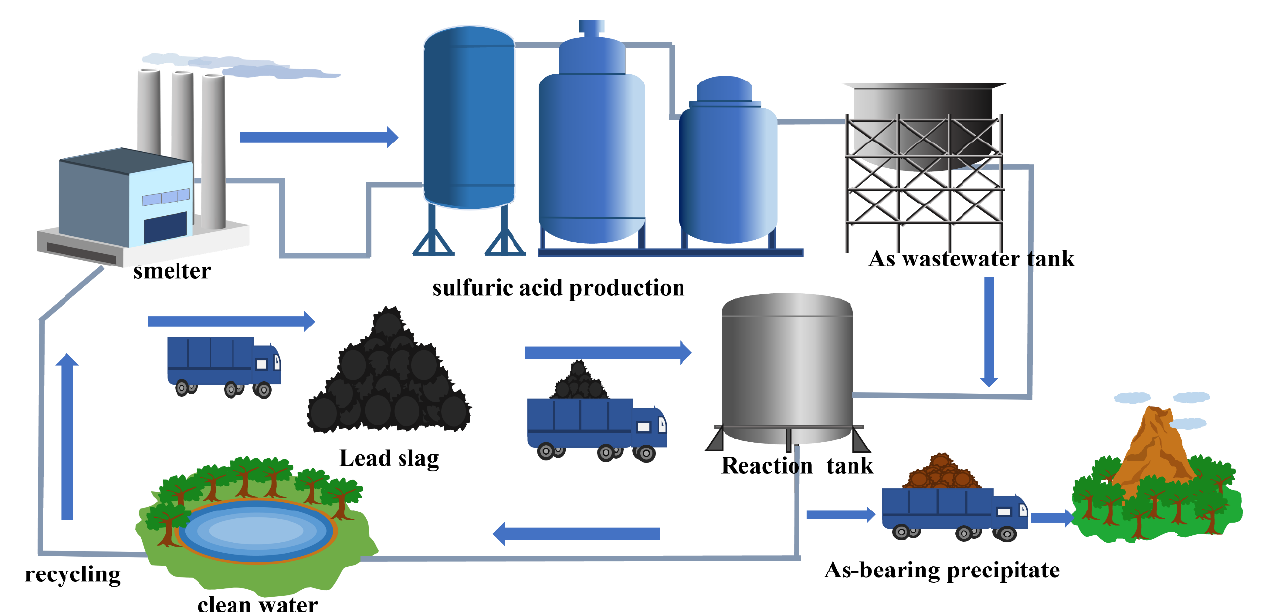
Figure 13. Flow diagram of co-treatment of lead smelting slag with arsenic-containing wastewater.